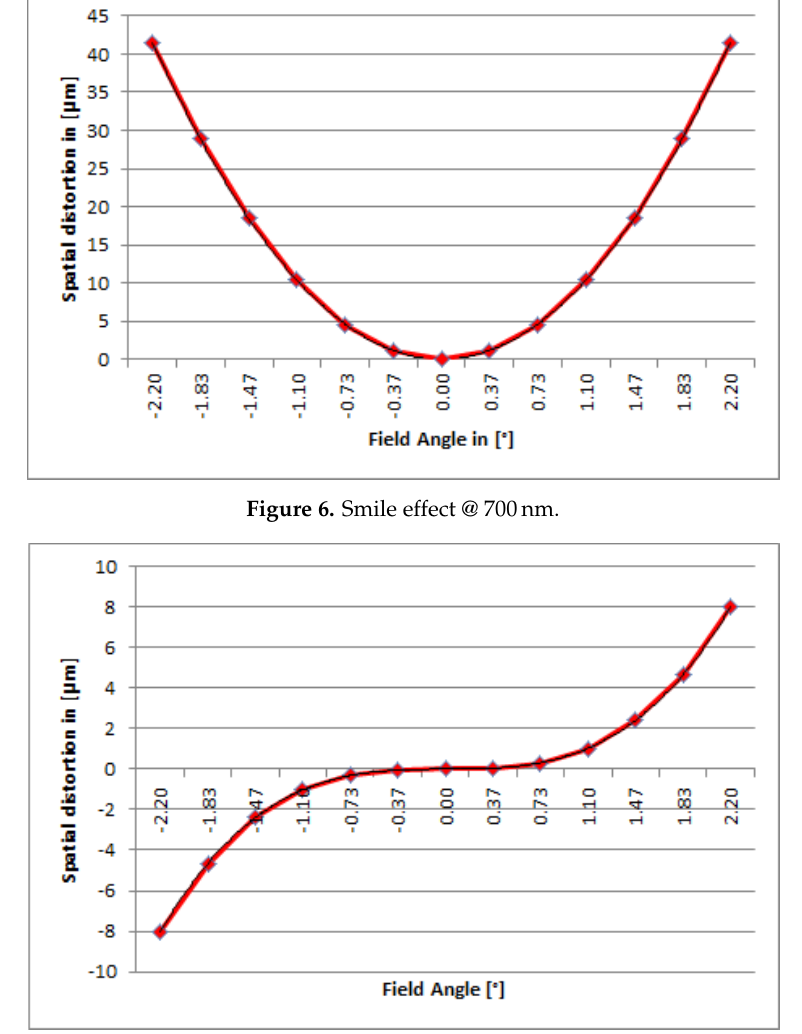
Figure 7. Spectral keystone effect @ 700